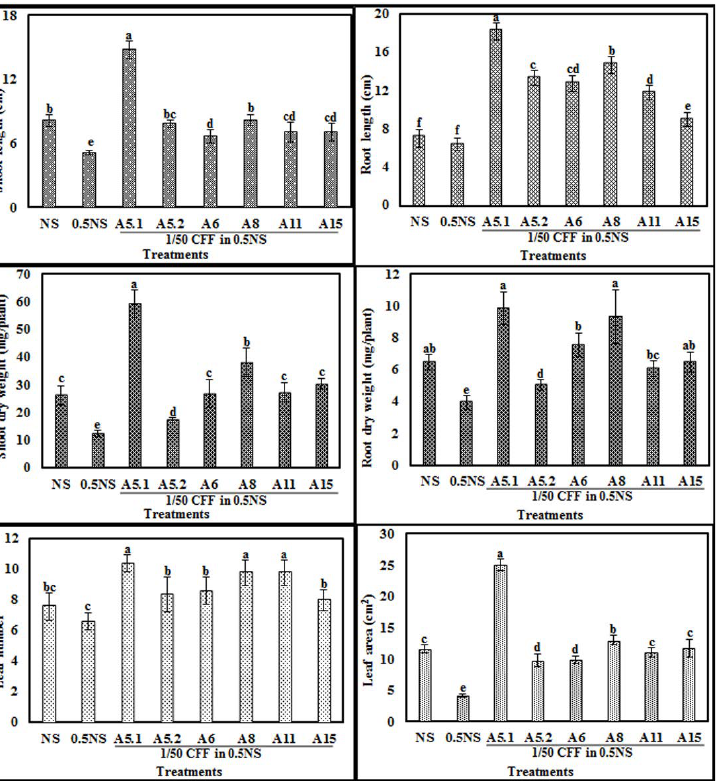
Figure 6. Effects of adding fungi cell-free filtrates CFFs (1/50) to half nutrient solution (0.5NS) compared to control full NS and 0.5NS on shoot length, root length, shoot dry weight, root dry weight, leaf number, and leaf area of tobacco seedlings grown in a hydroponic system. Values represent means and standard deviations (n = 5), where samples labeled with different letters are significant at p < 0.05.